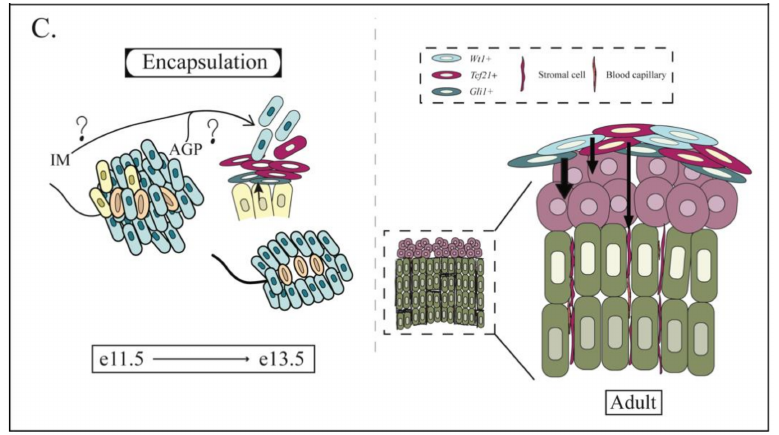
Figure 2. Key events in the late stages of fetal adrenal gland development and fate of the fetal adrenal cortex in mice: ( A ) Schematic model of medulla formation. Chromaffin cell differentiation requires the migration of a subpopulation of neural crest cells and their progressive differentiation into Schwann cell precursors and chromaffin cells. ( B ) Schematic model depicting the fate of the fetal adrenocortical cells. Before e14.5, adrenocortical fetal cells can differentiate into adrenocortical cells of the definitive cortex by first differentiating into capsular stem cells (or potentially by directly differentiating into cells of the definitive cortex), or they can proliferate and maintain the AP. After e14.5, cells from the AP do not contribute anymore to the definitive cortex formation. The progressive inactivation of Nr5a1 expression via NR5A1 SUMOylation and recruitment of NR0B1 to the FAdE leads to the regression of the fetal cortex/X-zone. ( C ) Schematics model for AP encapsulation. AP encapsulation requires the contribution of cells originating from both the fetal adrenal cortex and cells potentially originating directly from the AGP or the surrounding intermediate mesoderm. Different cell subpopulations have been identified including: Gli+ cells that are located the nearest to the adrenal cortex and that will eventually differentiate into steroidogenic cells of the definitive adrenal cortex; Wt1 + cells that have a more limited potential to differentiate into steroidogenic cells; and Tcf21 + cells that will differentiate into stromal cells of the definitive adrenal cortex. NCC = neural crest cells, NT = neural tube, SN = sympathetic neurons, SCP = Schwann cell